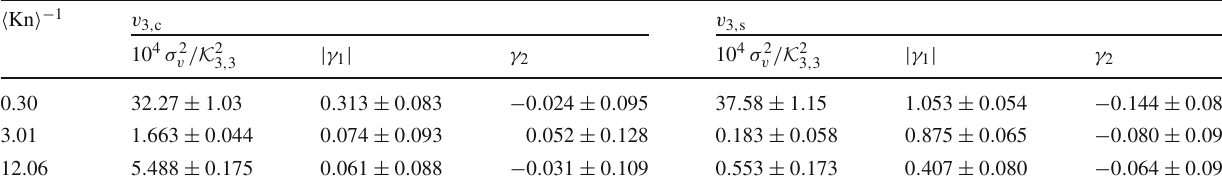
Table 10 Moments of the conditional probability distributions p v | ε (v 3 , c / s | ε 3 , c / s ) of the final-state flow harmonics computed for 10 4 events at b = 0 fm. The variance σ 2 v is divided by the square K 2